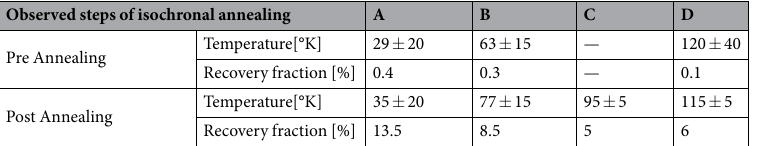
Observed steps of isochronal annealing